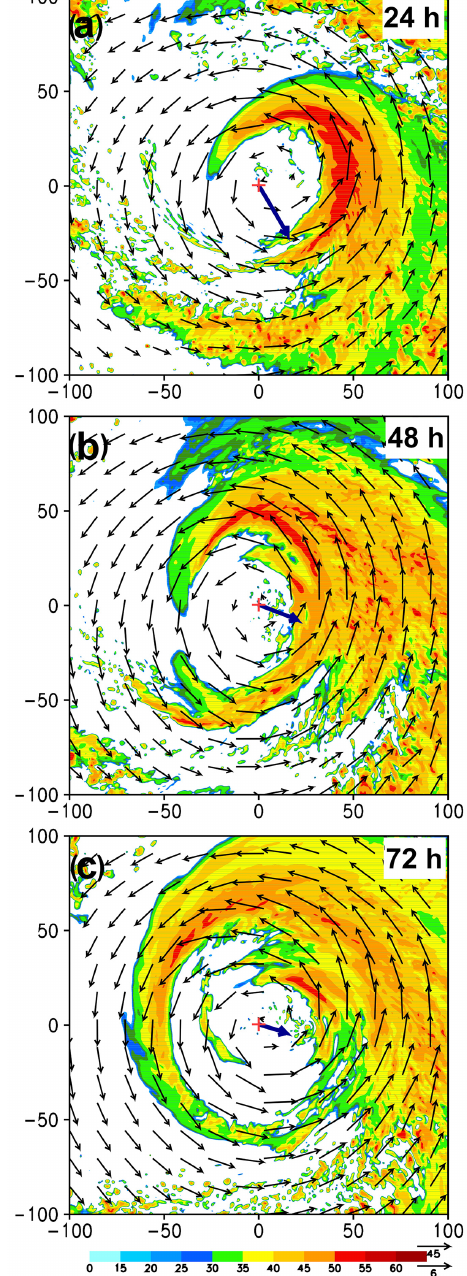
Figure 3. Simulated wind (vectors, ms − 1 ) , radar reflectivity (shad- ing, dBz) fields at 700hPa, and the vertical wind shear (bold arrows in the center) between 200 and 850hPa after (a) 24, (b) 48 and (c) 72h integration. The x and y axes indicate the distance (km) rela- tive to the storm center. The upper (lower) scale vector at the right lower corner is for the 700hPa wind (vertical wind shear).